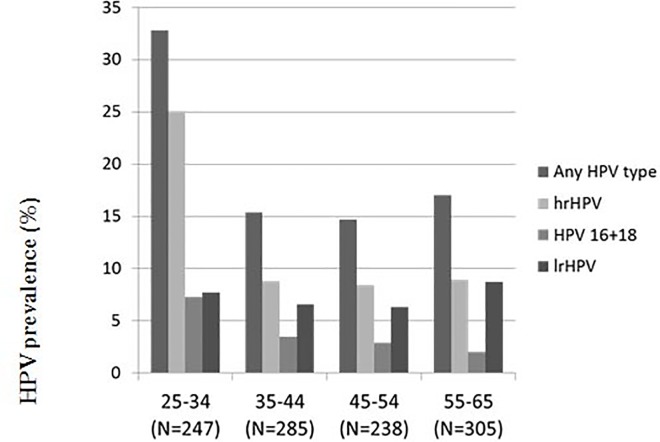
HPV genotype distribution in HPV positive women in the overall population stratified by age (both single as multiple infections included) (N = 1075).High risk HPV illustrate12 hrHPV types 16/ 18/31/ 33/ 35/ 39/ 45/ 51/ 52/ 56/ 58/ 59 and 6 possible hrHPV types 26/ 53/ 73/ 82/ 66/ 68. The vaccine types hrHPV 16,18, 31, 33, 45, 52,58 are included. Underlying numbers are presented in S2 table.